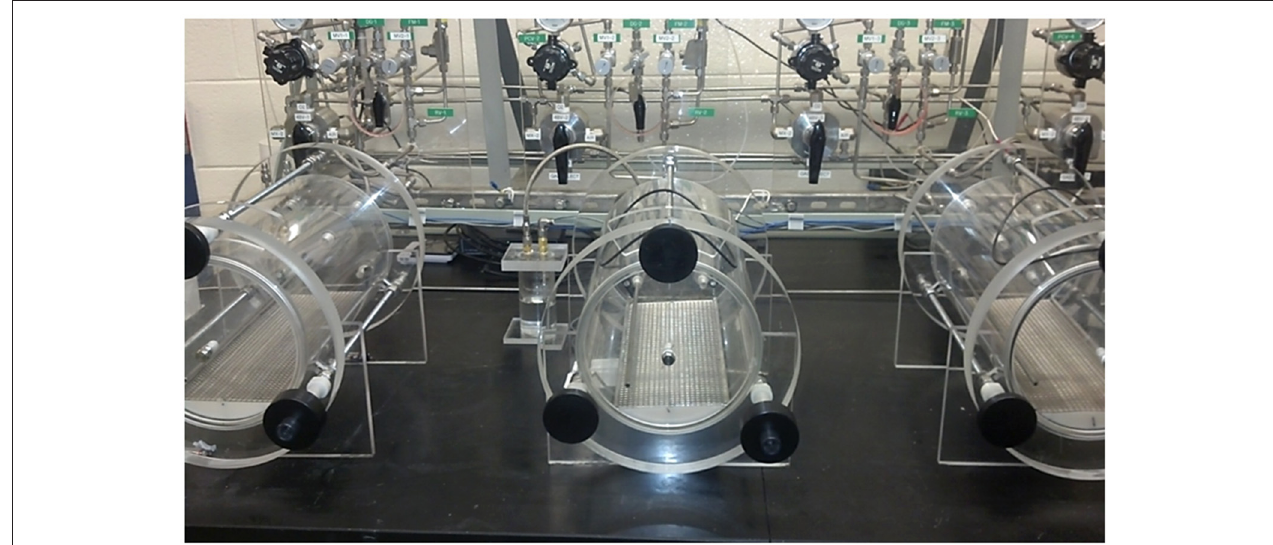
FIGURE 1 | Hypobaric